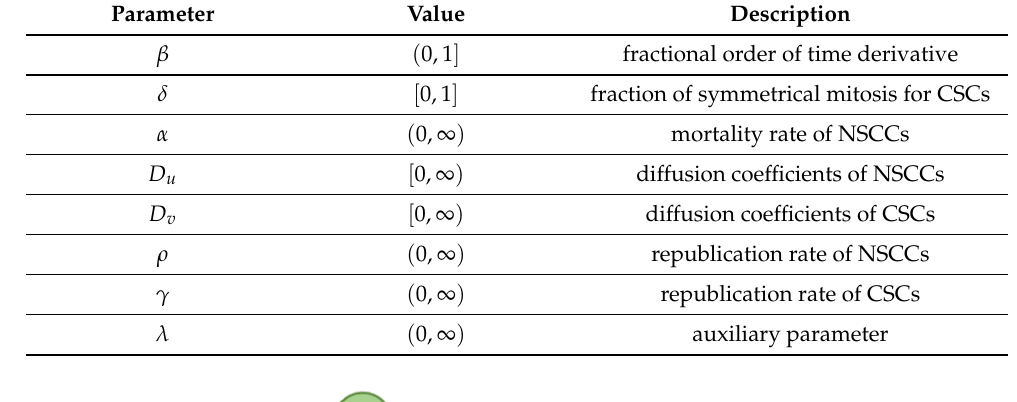
Table 1. Names and descriptions of parameters.